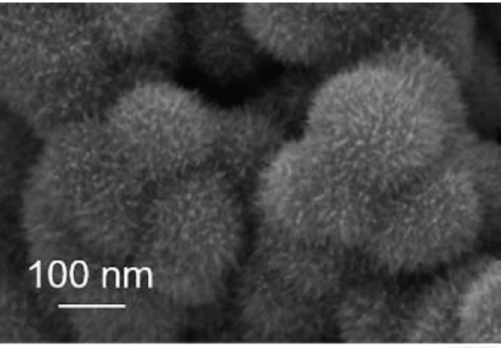
Figure 14. SEM image of urchin-like IrO 2 nanostructures (Reprinted/adapted with permission from Ref. [113]).